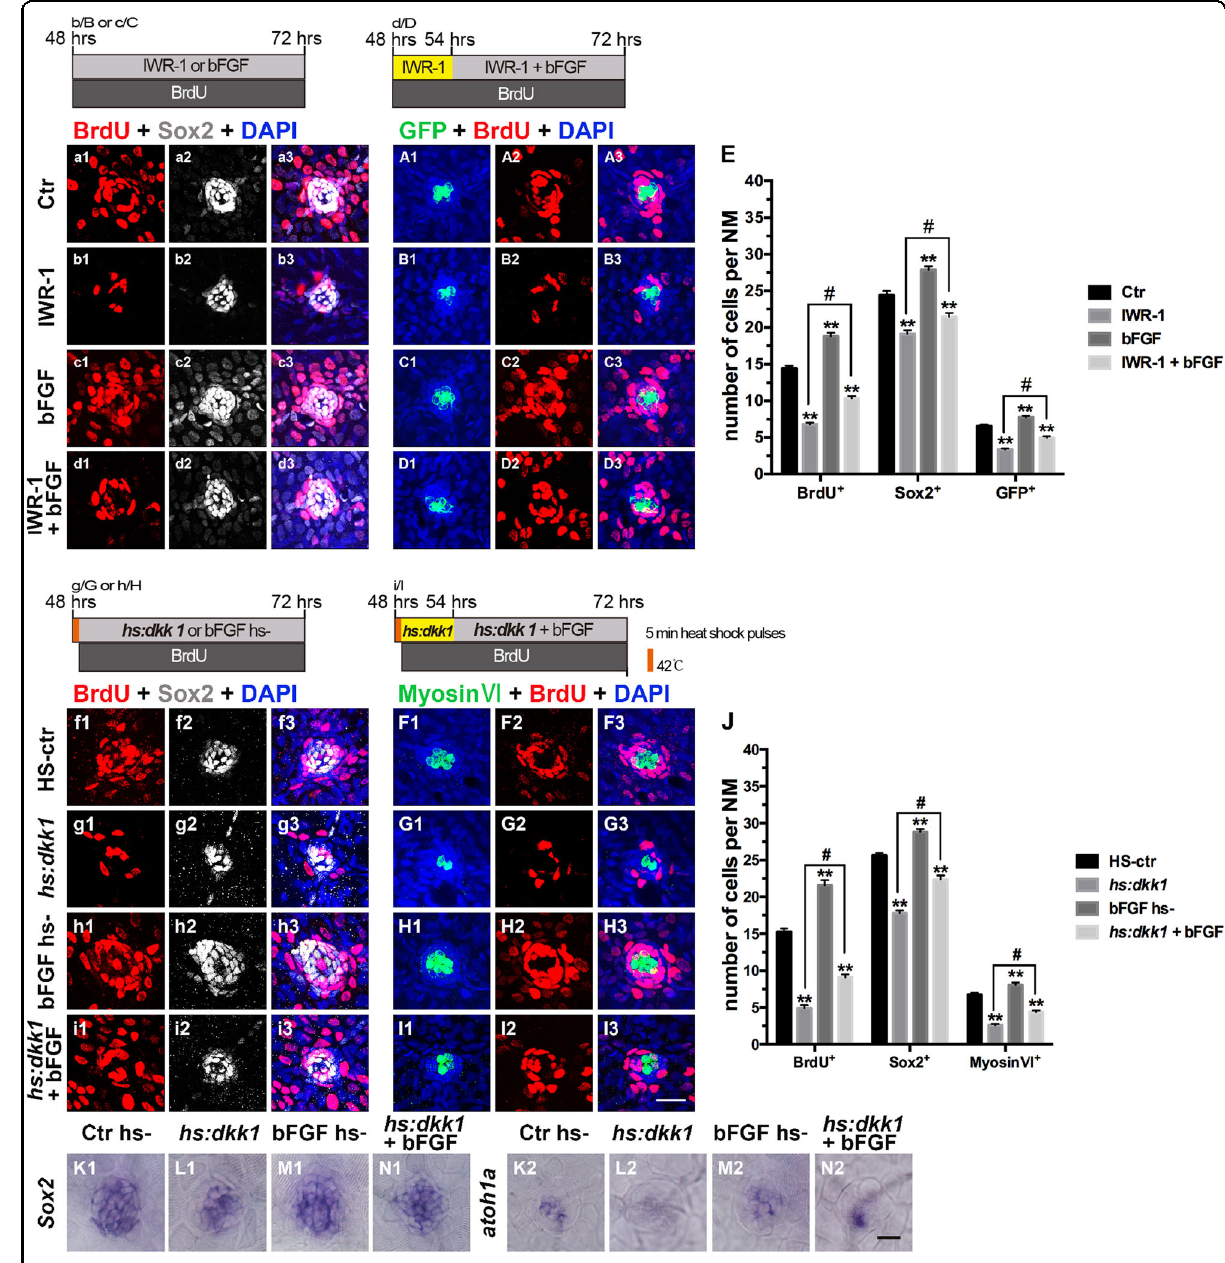
Fig. 4 Effects of FGF activation on cell proliferation in Wnt-inhibited larvae. a1 – D3 : Proliferative cells labeled with BrdU (red), SCs labeled with Sox2 (white), and HCs labeled with GFP (green). a 1 – A 3: Control neuromast; b1 – B3 : After addition of IWR – 1; c1 – C3 : After addition of bFGF; d1 – D3 : After 6 h of incubation with IWR – 1, bFGF and IWR – 1 were added for 18 h; e : Quanti fi cation of the proliferative cells (BrdU + ), SCs (Sox2 + ), and HCs (GFP + ) shown in a1 – D3 . f1 – I3 : Proliferative cells labeled with BrdU (red), SCs labeled with Sox2 (white), and HCs labeled with myosin VI (green). f1 – F3 : Heat shock-negative control larvae (HS – ctr); g1 – G3 : Wnt repression by heat shock induction of the hs:dkk1 transgene ( hs:dkk1 ); h1 – H3: After addition of bFGF; i1 – I3 : At 54 hpf, hs:dkk1 embryos were treated with bFGF for 18 h. j : Quanti fi cation of the proliferative cells (BrdU + ), SCs (Sox2 + ), and HCs (myosin VI + ) shown in f1 – I3 . n = 5 – 7 fi sh per group. ** Indicates p < 0.001, # indicates p < 0.05, and error bars indicate the standard error of the mean. K1 – N1 and K2 – N2 : WISH analysis of Sox 2 ( K1 – N1 ) and atoh1a ( K2 – N2 ) expression in the neuromasts from different groups. Scale bar in I3 = 20 μ m for a1 – D3 and f1 – I3 . Scale bar in N2 = 30 μ m for K1 – N1 , K2 –